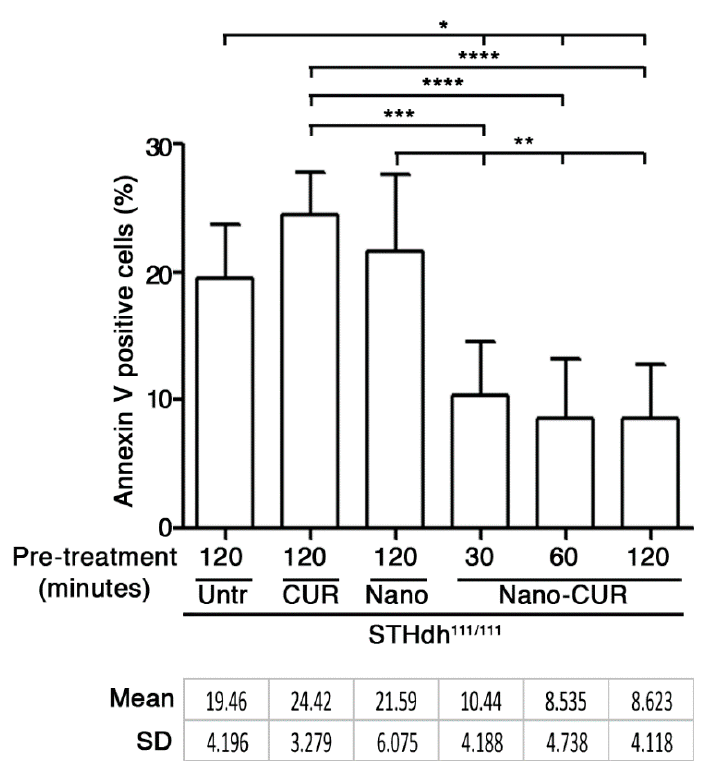
Figure 5. Apoptosis in STHdh 111/111 HD striatal-derived cells pre-cultured with serum-free medium (Untr) in presence of pure curcumin (CUR), empty nanoparticles (Nano) and CUR-loaded nanoparticles (Nano-CUR) at different time points. Percentage of apoptotic (Annexin-V positive) cells is expressed as mean ± SD of three experiments, each performed in duplicate. * p < 0.05; ** p < 0.01; *** p < 0.001; **** p < 0.0001 (One-Way ANOVA with Tukey post-test). Untr: untreated; CUR: curcumin; Nano: empty nanoparticles; Nano-CUR: curcumin-loaded nanoparticles.